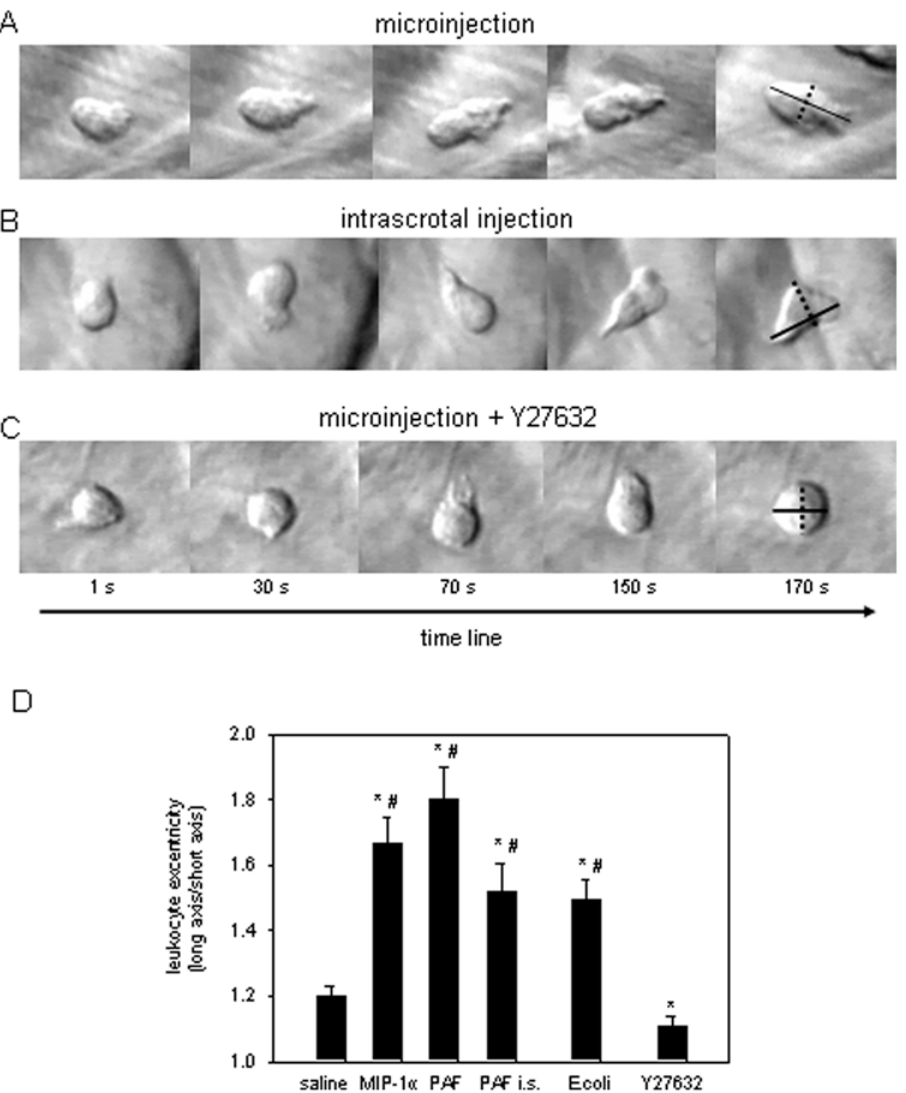
Figure 7. Morphological changes and polarization of interstitially migrating leukocytes. Freeze-frames from in vivo microscopy video recordings obtained 60 min after microinjection of PAF (A), 60 min intrascrotal injection of PAF (B), and 60 min microinjection of PAF in combination with superfusion of the Rho kinase inhibitor Y27632 for 30 min (C; objective magnification 40 6 ). A: directional locomotion of a leukocyte towards the attractant with protrusions of lamellipodia at the front and a trailing uropod after microinjection of PAF. B: polarized leukocyte during random migration in the interstitial tissue after intrascrotal injection of PAF. C: blocking effect of Rho kinase inhibitor Y27632 on leukocyte polarization induced by microinjection of PAF. D: leukocyte polarization was measured as cell eccentricity: long axis (shown in black line)/short axis (depicted as interrupted line). Quantitative data of cell eccentricity after microinjection of saline, MIP-1 a , PAF, E. coli , intrascrotal injection of PAF, as well as after microinjection of PAF with superfusion of Y27632; mean 6 SEM; *p , 0.05 vs. saline, # p , 0.05 vs. Y27632;